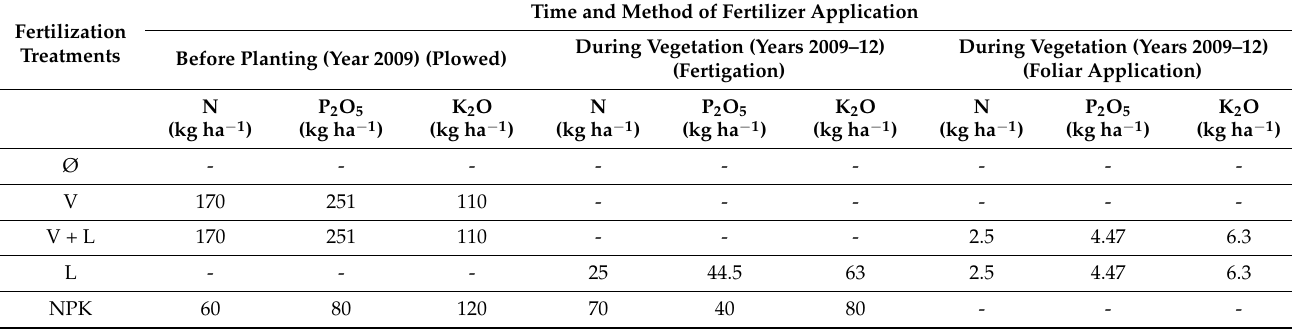
Table 1. Total amounts of nitrogen, phosphorus, and potassium applied through different fertilization treatments, time, and method of fertilizer